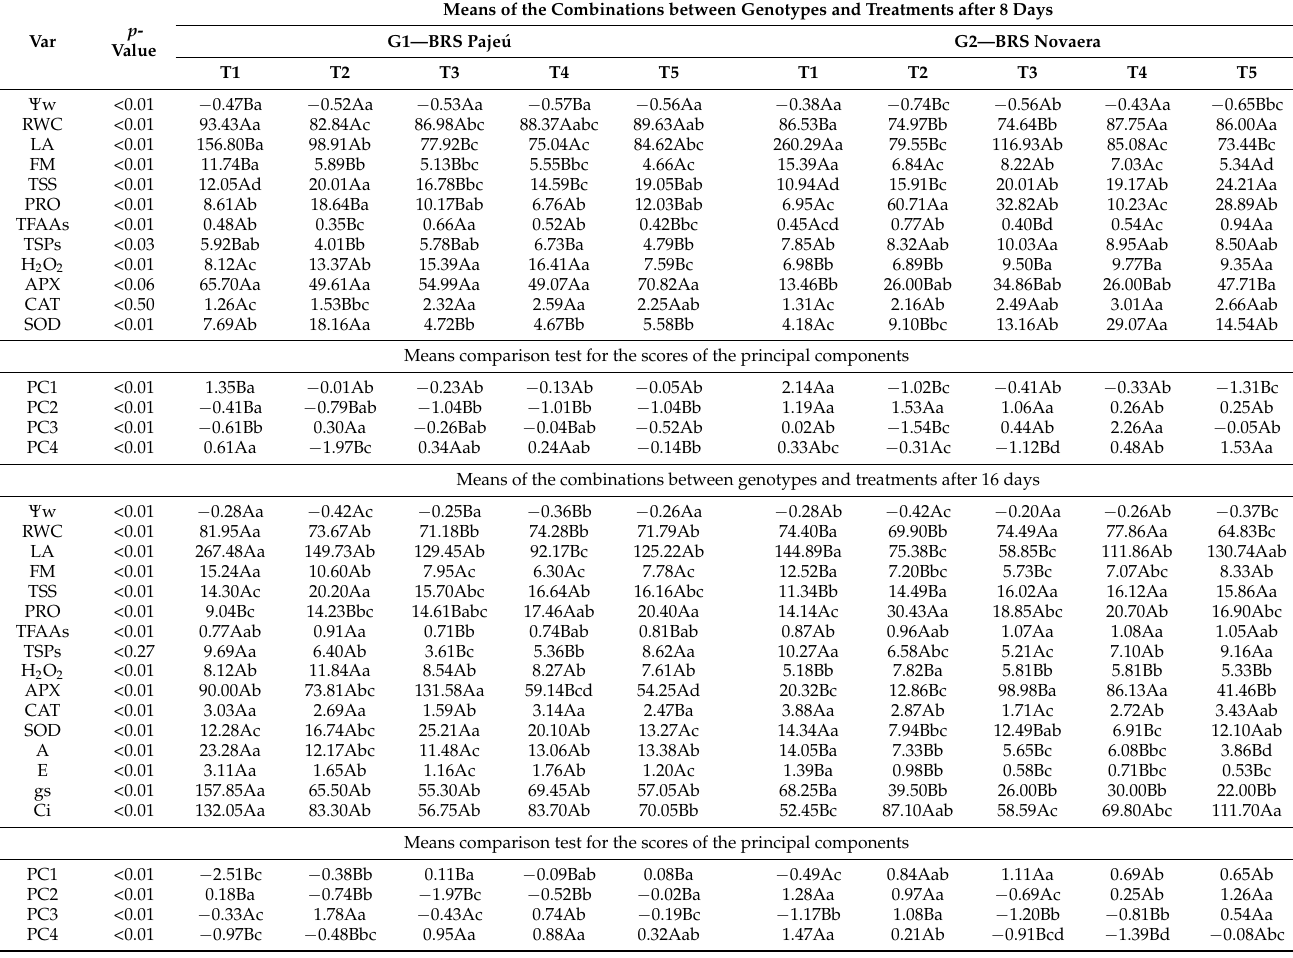
Table 2. Means of the original variables and scores of the principal components eight and sixteen days after application of